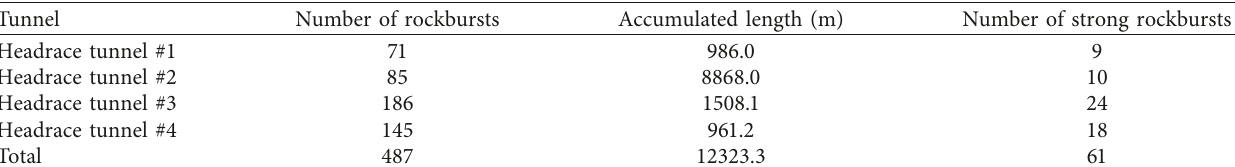
Table 1: Rockburst in the headrace tunnels at chainage 4+000 ‒ 12 +000m [45].